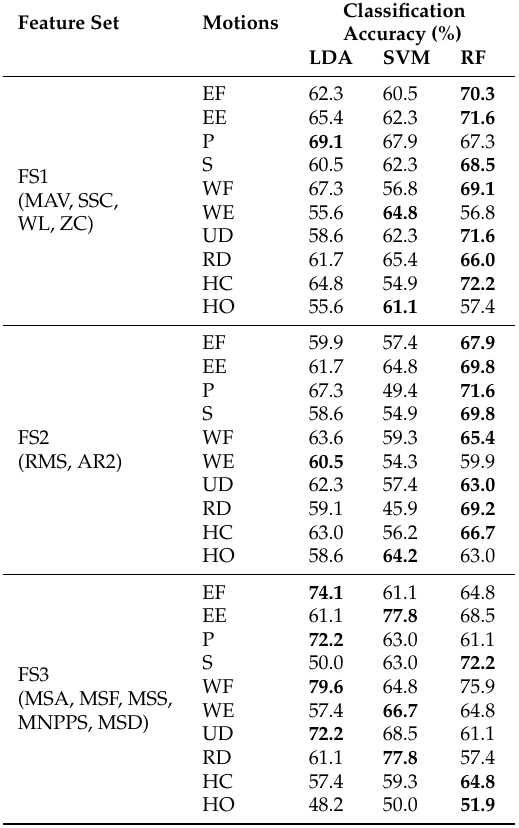
Table 2. Classification accuracies for each preliminary feature set. The best classification result for each motion within each feature set is in bold.